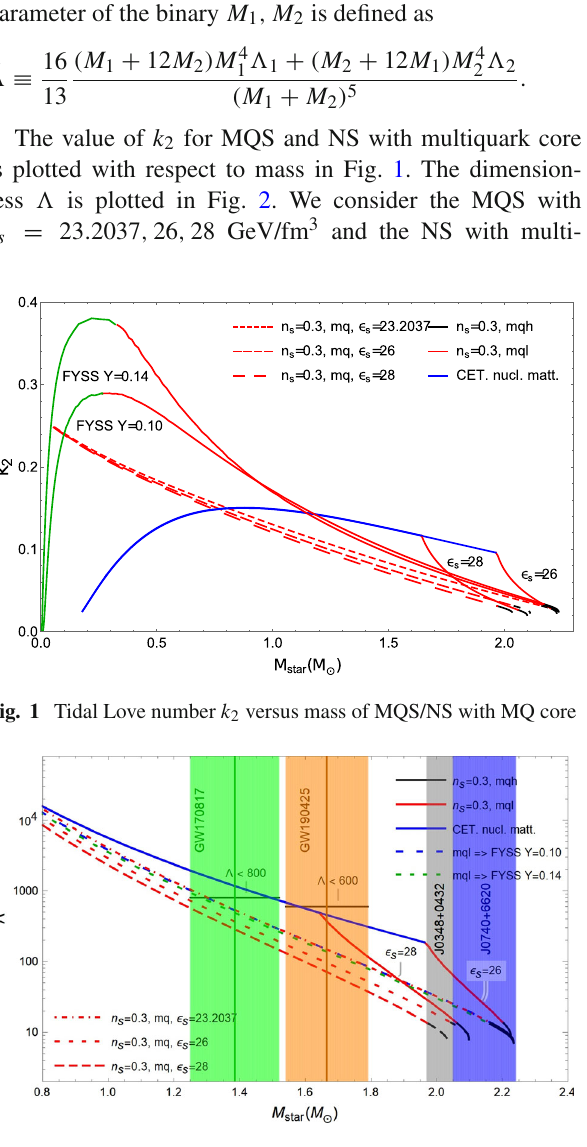
Fig. 2 Dimensionless tidal deformation (cid:2) versus mass of MQS/NS with MQ